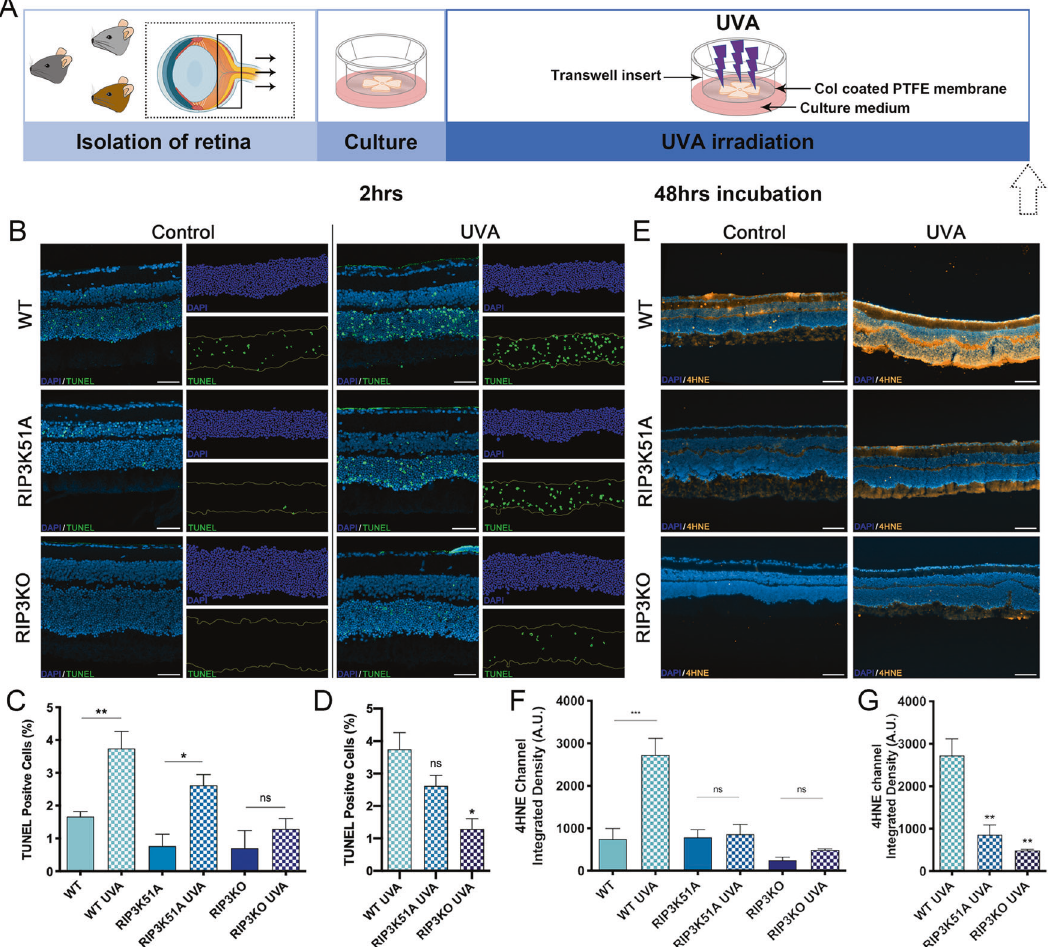
Fig. 7 Knockout of RIPK3 reduces the number of cell death and the level of oxidative stress. A Flow chart of retina explant culture ex vivo and UVA irradiation model. B – D Representative images and analysis of sections stained with DAPI (Blue) and TUNEL (Green) from WT, RIP3K51A and RIP3KO mouse retinal explants, showing control and treatment (UVA 10.5 J/cm2) groups ( n = 3). Scale bar = 50 µm. Image J post processed images are displayed next to each original picture. E – G Representative images and analysis of sections stained with DAPI (Blue) and 4HNE (Orange) from WT, RIP3K51A and RIP3KO mouse retinal explants, showing control and treatment (UVA 10.5 J/cm 2 ) groups ( n = 3). Scale bar = 100 µm. Statistical signi fi cance was analyzed with ANOVA followed by Bonferroni ’ s multiple comparison test between selected